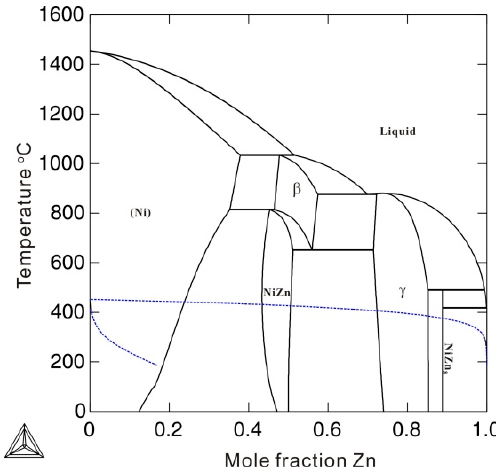
Figure 2. Calculated phase diagram of a binary Ni-Zn system according to the thermodynamic description by Xiong et al. [11]. The blue dashed lines are the artificial phase boundaries of the bcc_A2 phase.